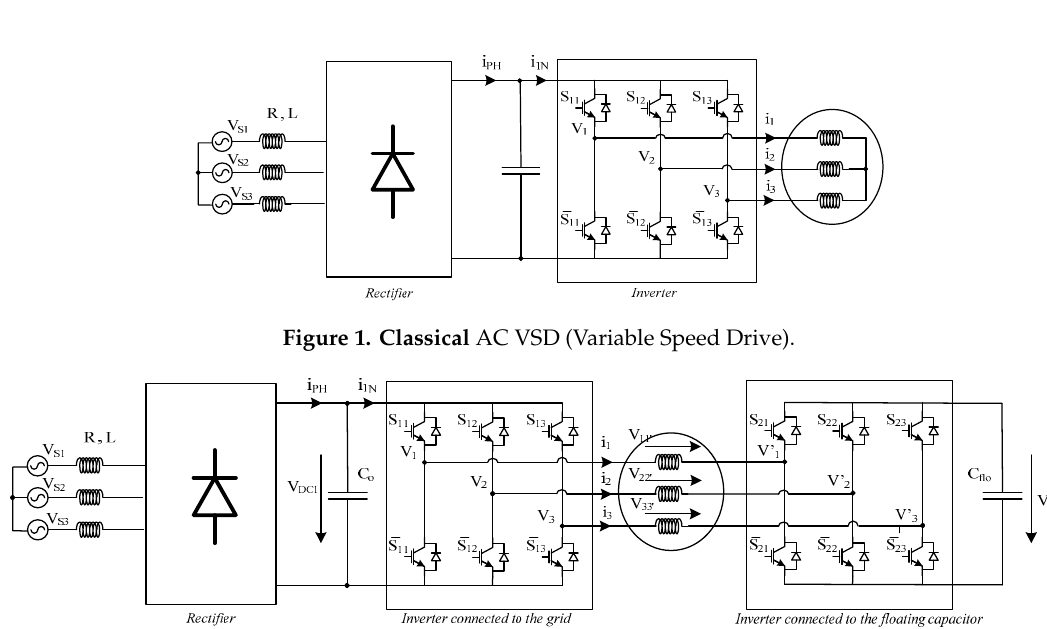
Table 1. Summary of several topologies.